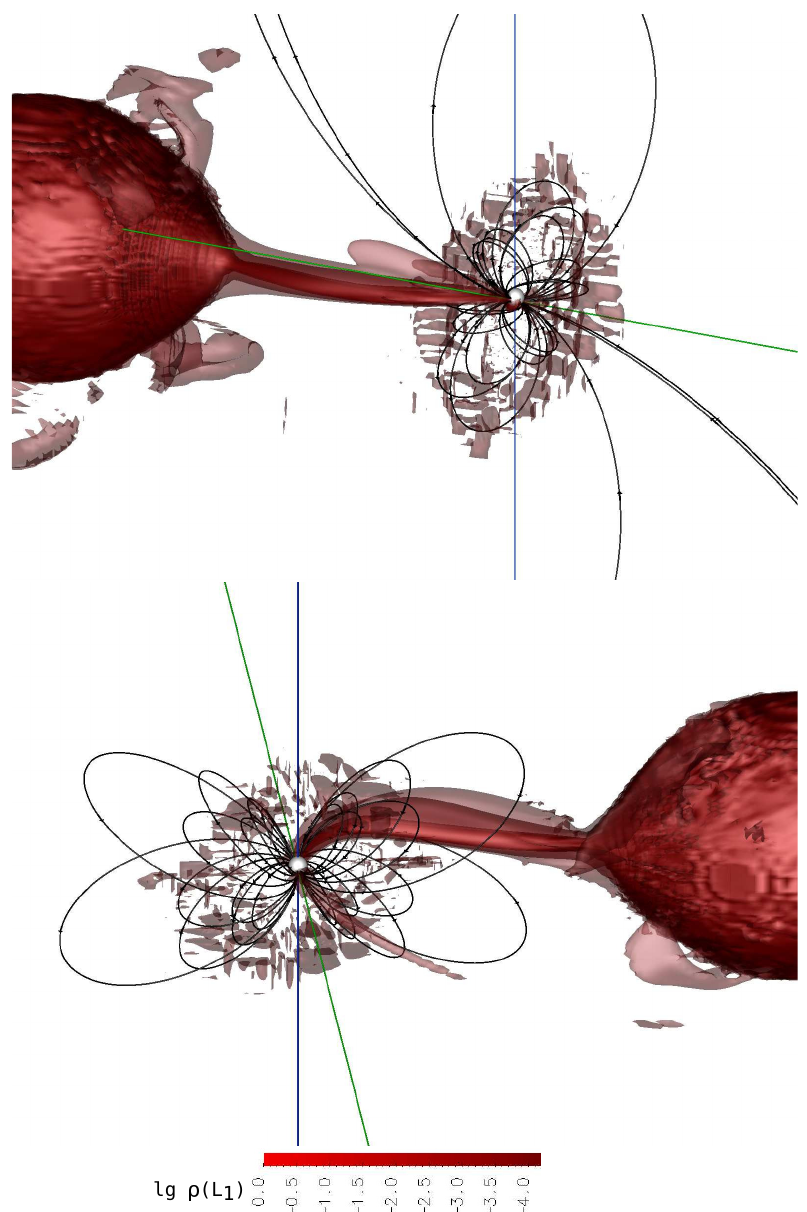
Figure 8. The same as Figure 6 but for phases 0.4 ( upper panel) and 0.5 ( lower panel). The system is shown from the point of view of an Earth observer at the orbital phase 0.3 for upper panel and phase 0.7 for lower